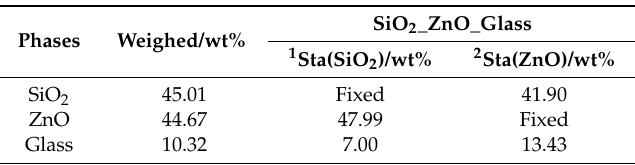
Table 3. Rietveld quantitative results, including amorphous component derived by internal method for the artificial mixture, using the corrected values of Table 2.